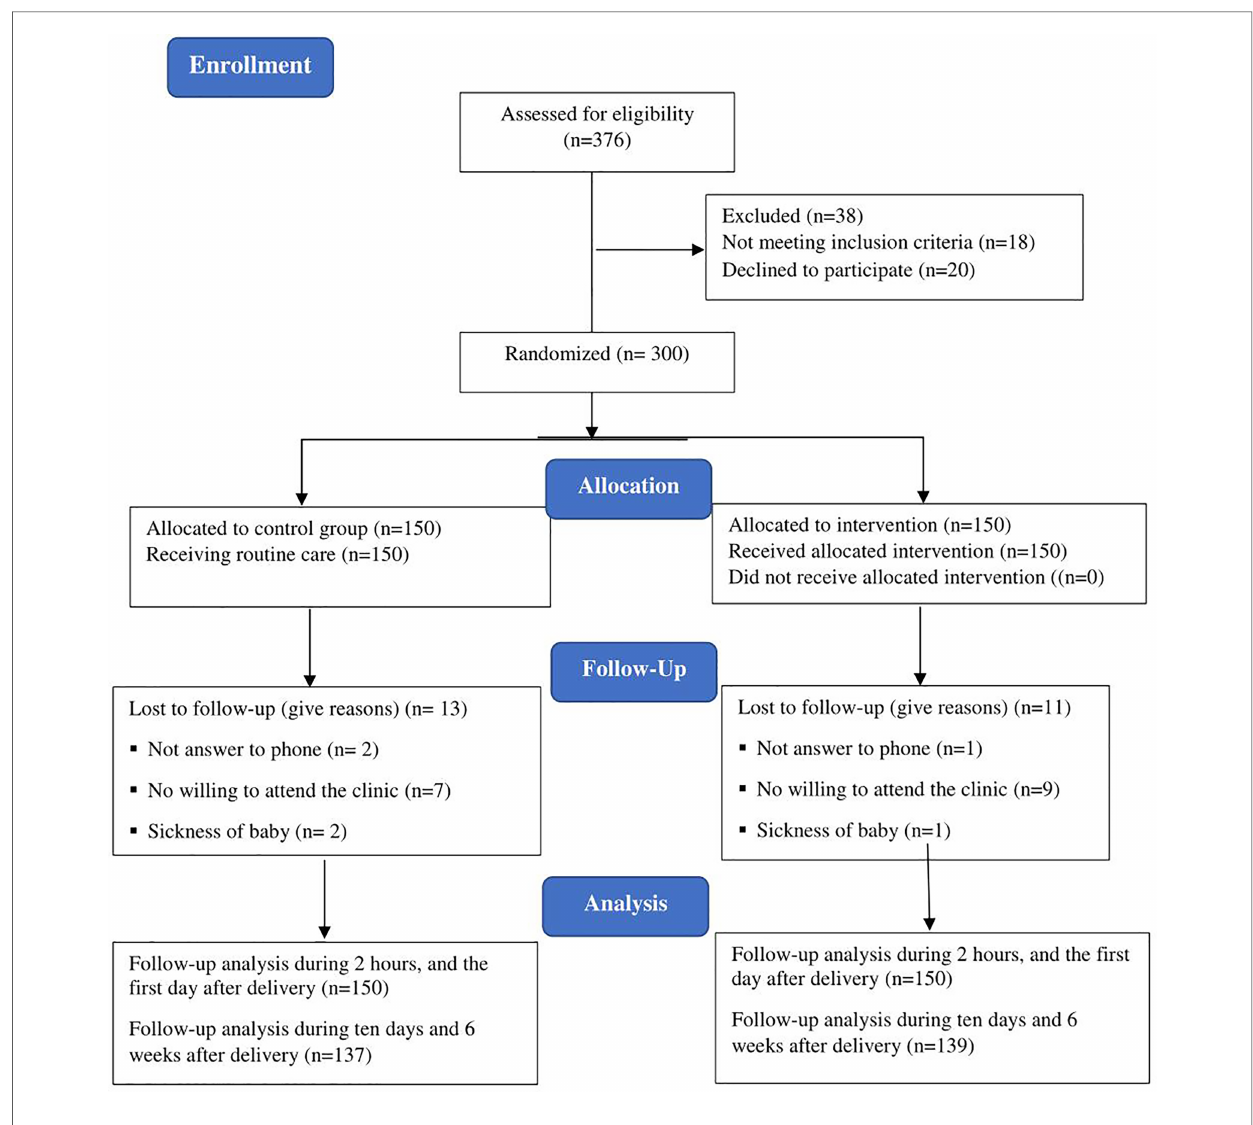
FIGURE 1 Flow diagram of the participants through the